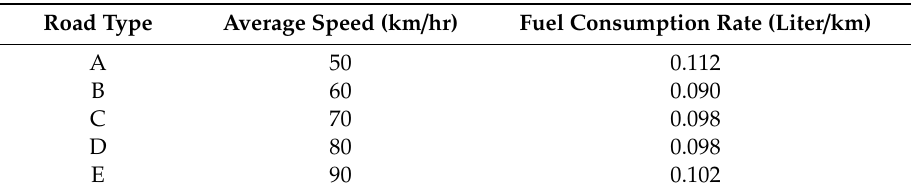
Table 1. The road type and fuel consumption rate.